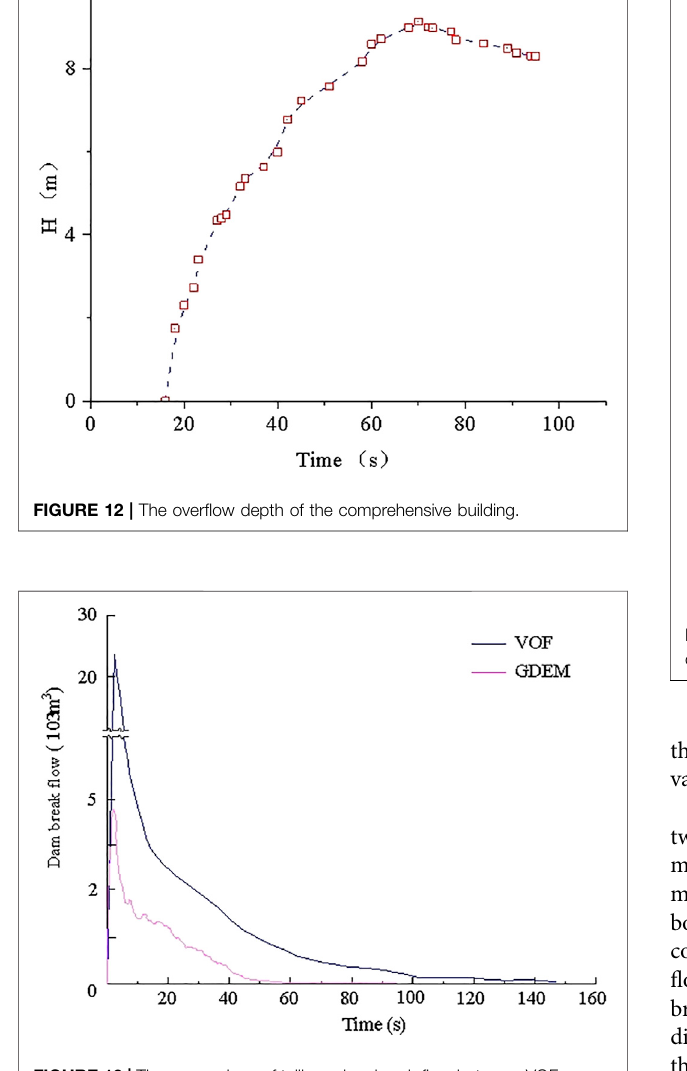
FIGURE 13 | The comparison of tailings dam break fl ow between VOF and GDEM.